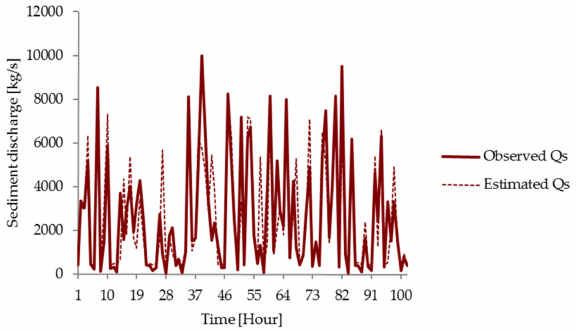
Figure 9. Observed and estimated sediment discharge at training stage using MLP.